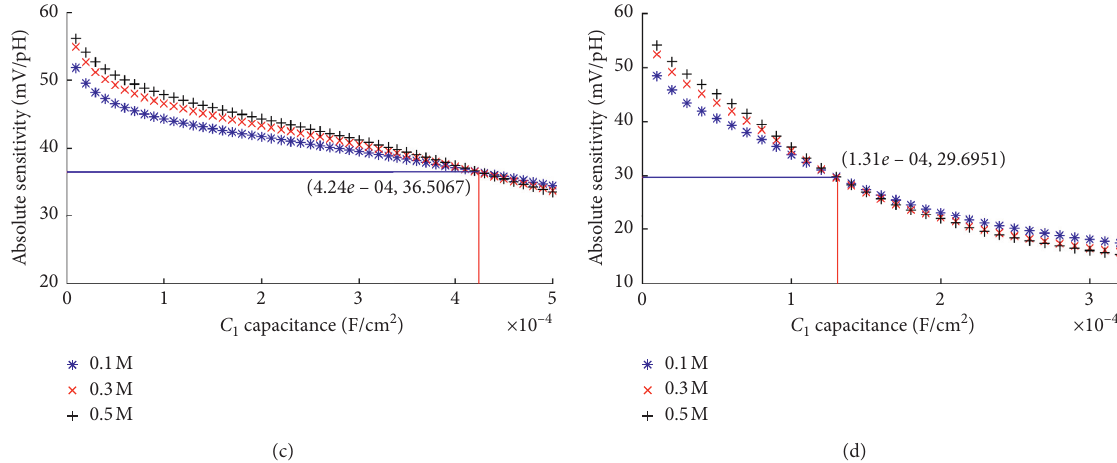
Figure 6: Absolute sensitivity against C 1 capacitance for (a) TiO 2 , N s : 7 (anatase), ε s : 35, (b) Ta 2 O 5 , N s : 4, ε s : 50, (c) Ta 2 O 5 , N s : 6, ε s : 50, and (d) Al 2 O 3 , N s : 1.3, ε s : 10.43. The electrolyte is KCl for all